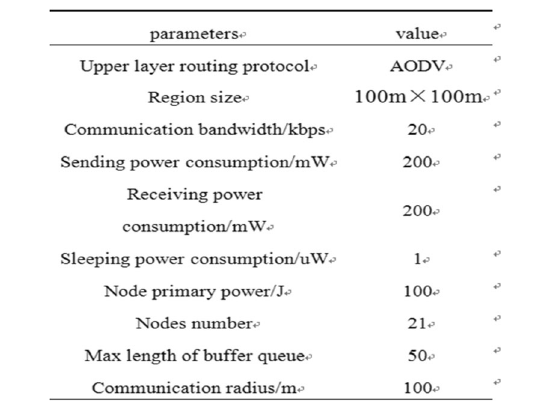
Table 1 Some simulation parameters of experiment